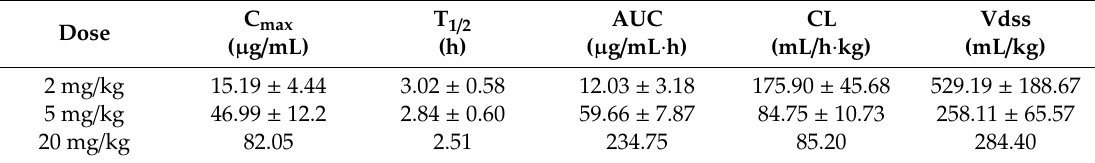
Table 1. Pharmacokinetic parameters of dogs after intravenous administration of three doses of glucose-conjugated chlorin e6.